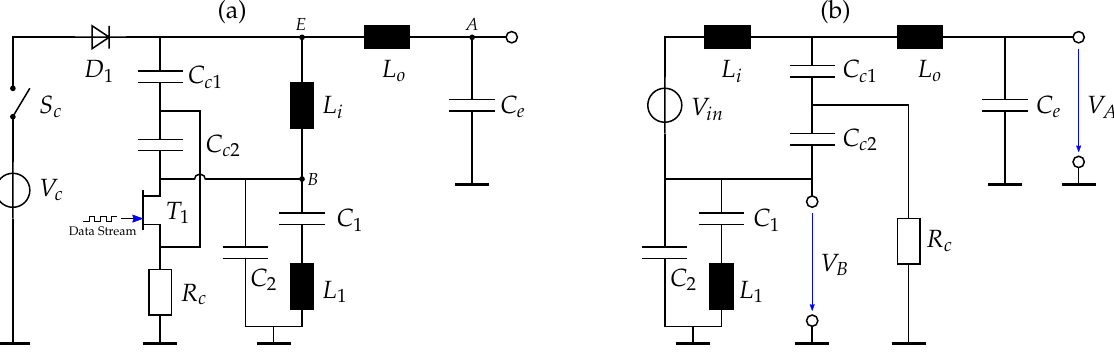
Figure 5. Interconnected oscillators ( a ) and the simplified equivalent circuit used for calculating the transfer functions ( b